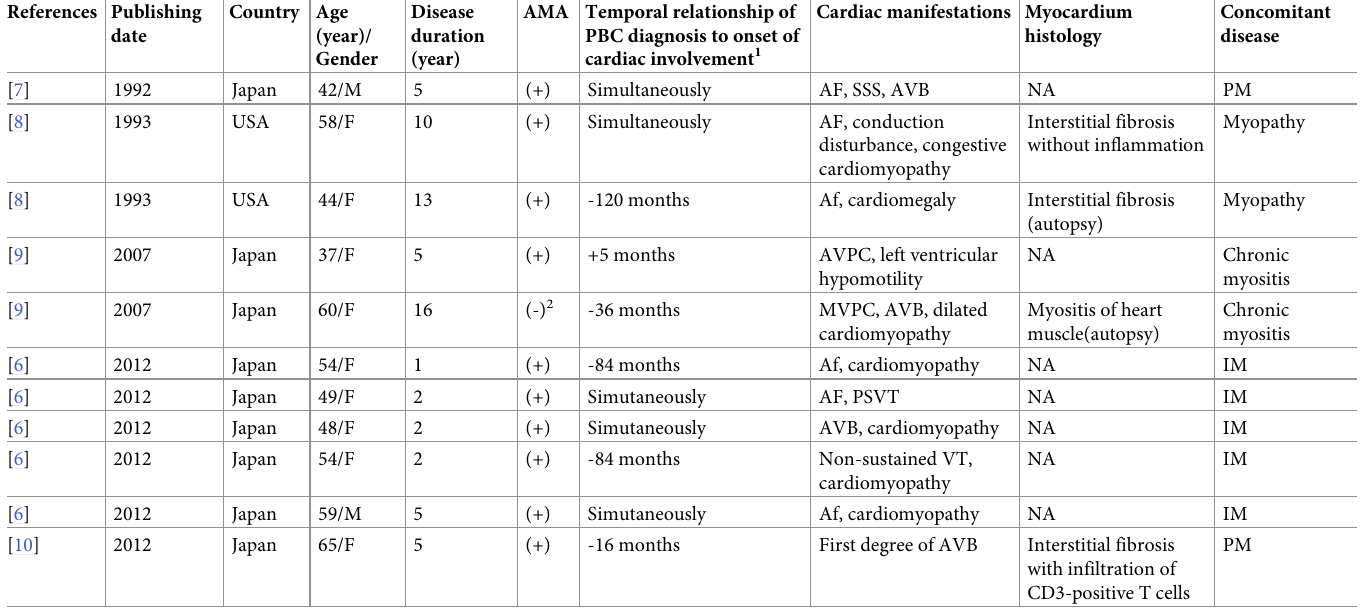
Table 3. Literature review of cases of PBC with cardiac